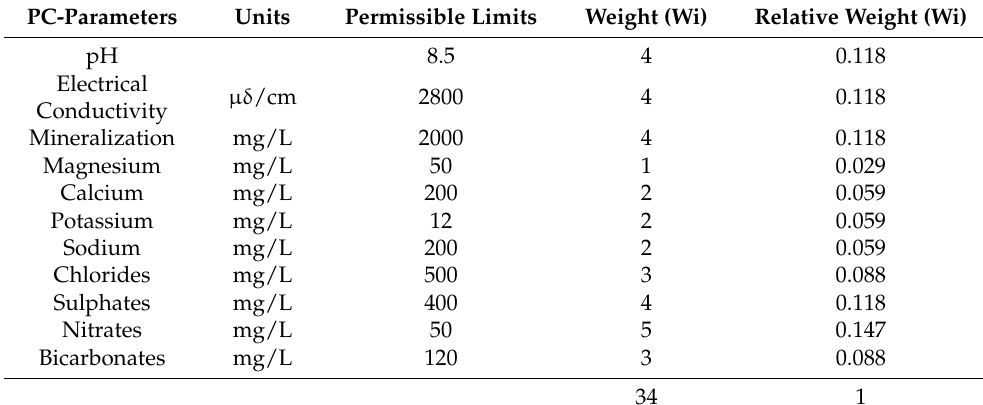
Table 1. The weighting of each physicochemical parameter.